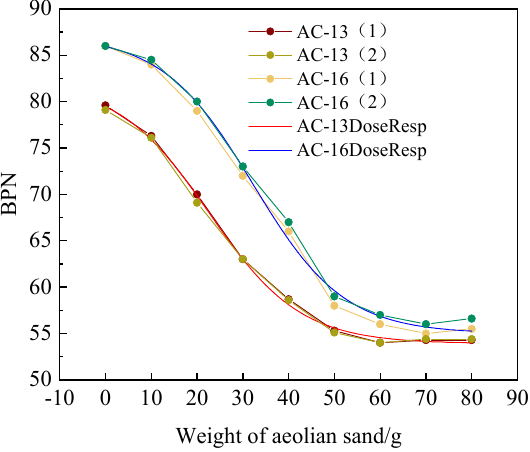
Figure 9. BPN value under different aeolian sand weight.